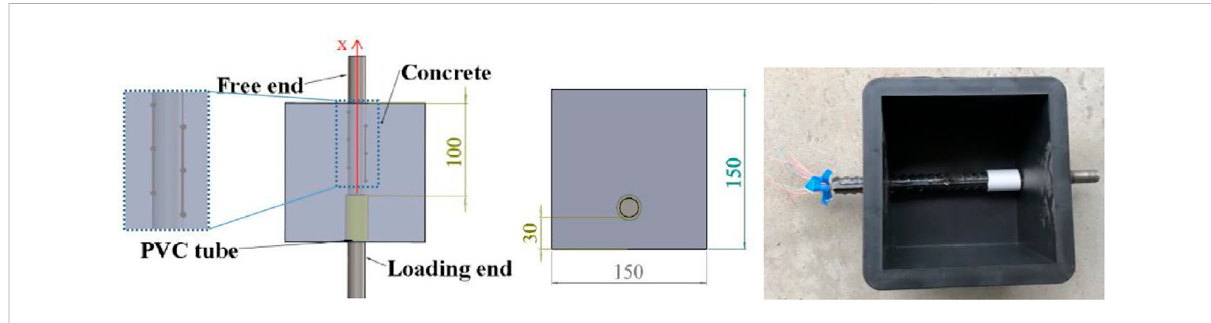
FIGURE 1 Dimension of pull-out specimens (unit: mm).